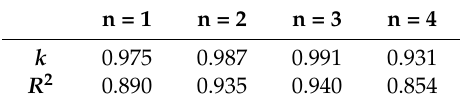
Table 1. Denoising evaluation parameters of db5 LWT under different decomposition scales.